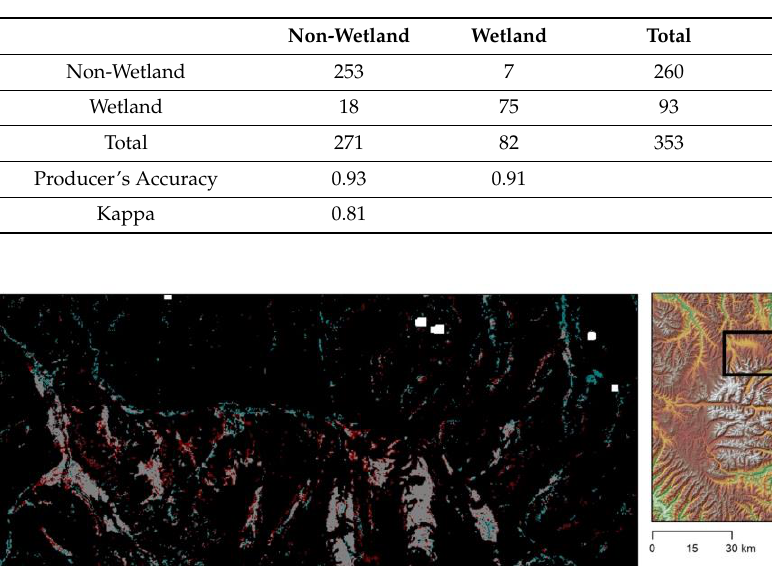
Table 3. Confusion Matrix After Filtering by Elevation and Slope for 2004 Image.